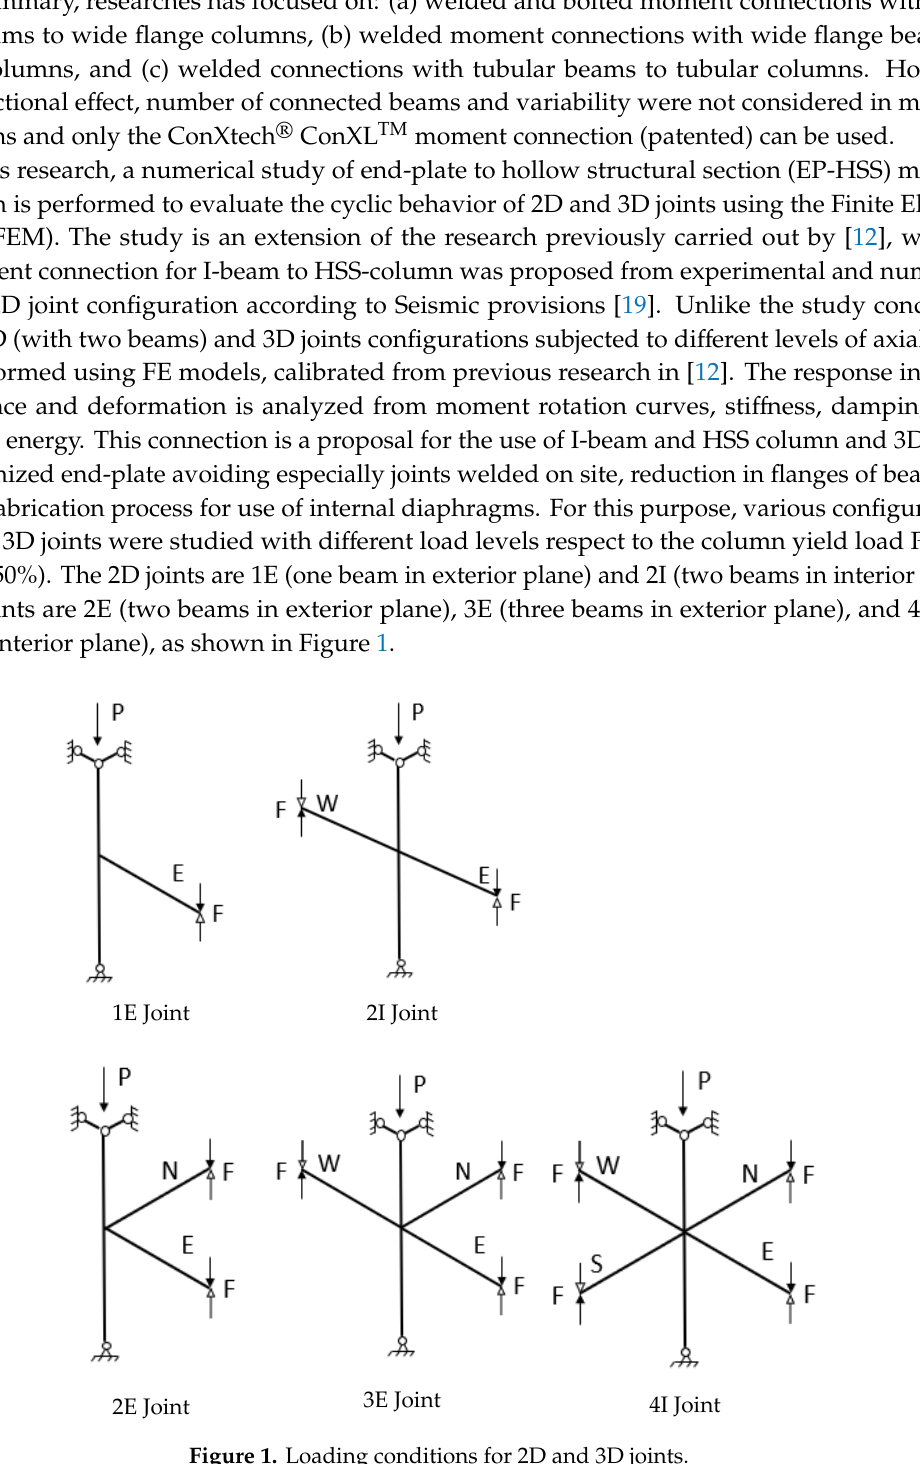
Figure 1. Loading conditions for 2D and 3D joints.